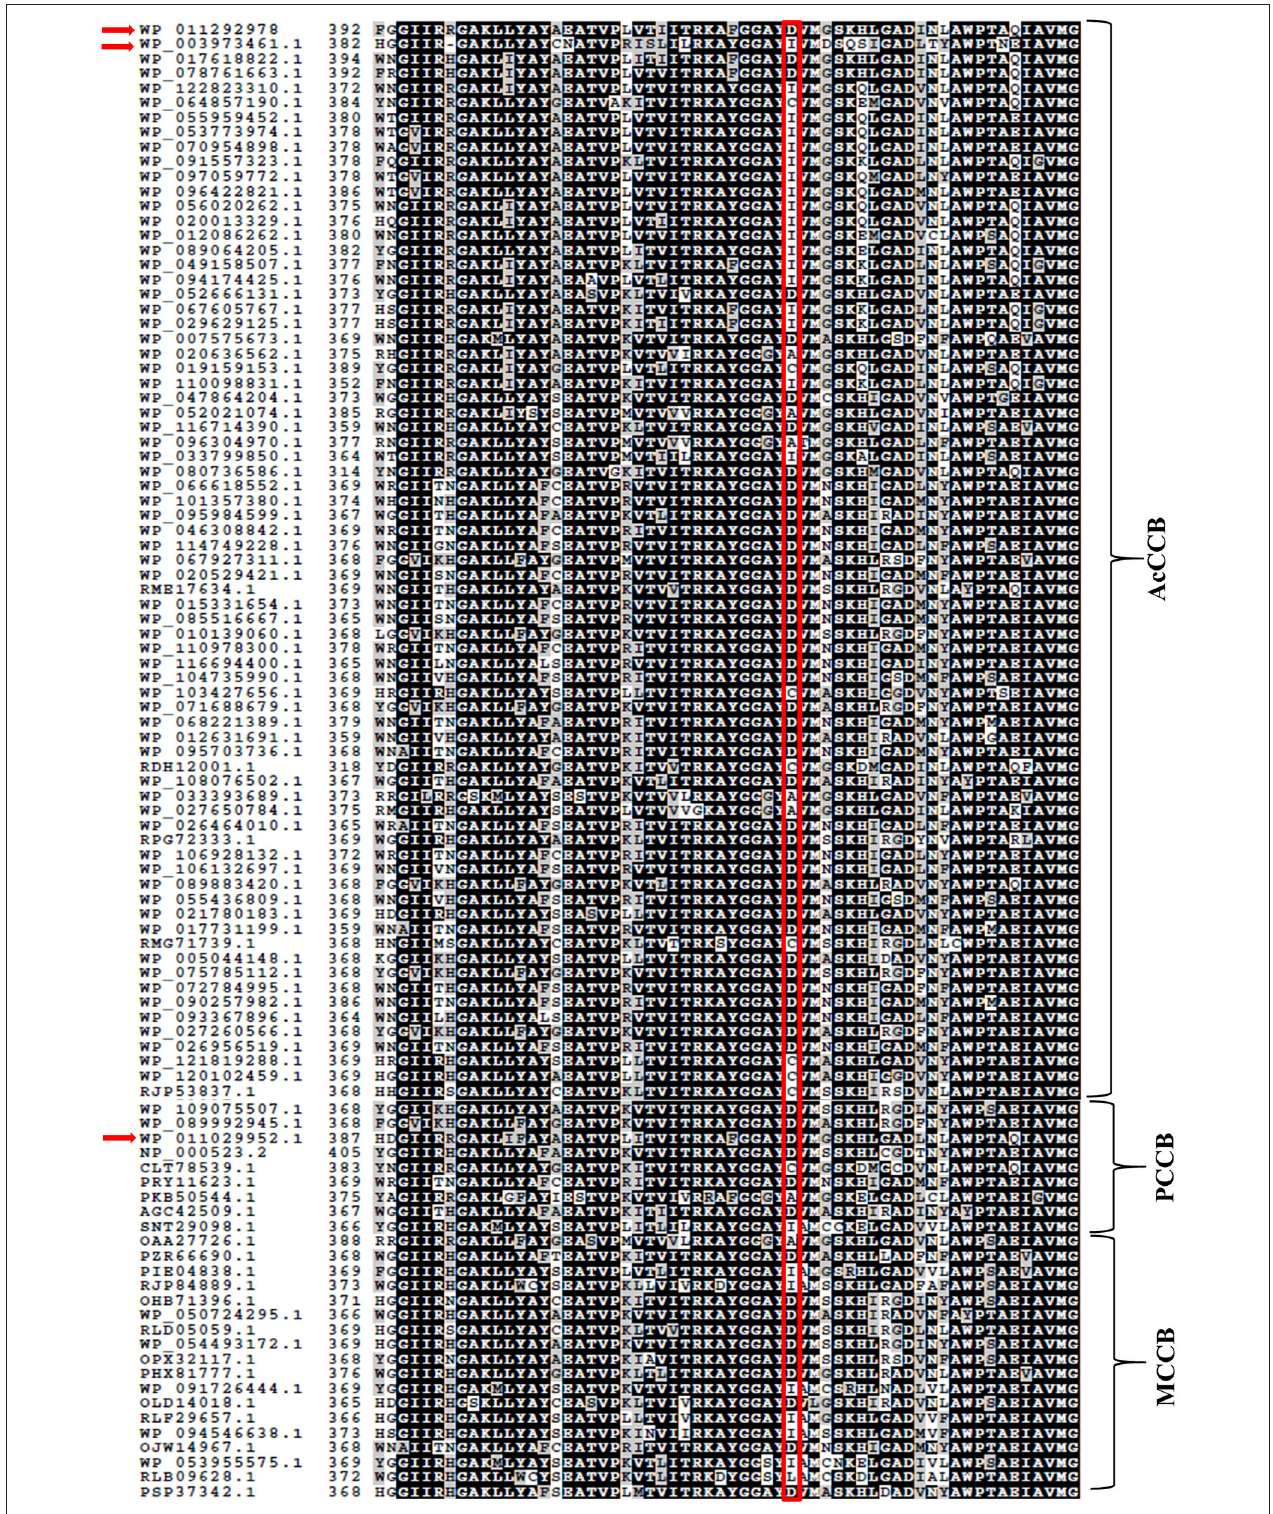
FIGURE 4 | Amino acid sequence comparisons of CT subunits of AcCCase, PCCase and 3-methylcrotonyl-CoA carboxylase (MCCase) enzymes. Highlighted is the conserved Asp residue, near the C-terminus of these proteins that may play a role in determining the substrate specificity of these enzymes. The sequences of TfAcCCB (WP_011292978), ScAcCCB (WP_003973461.1), and ScPccB (WP_011029952.1) subunits are arrowed.